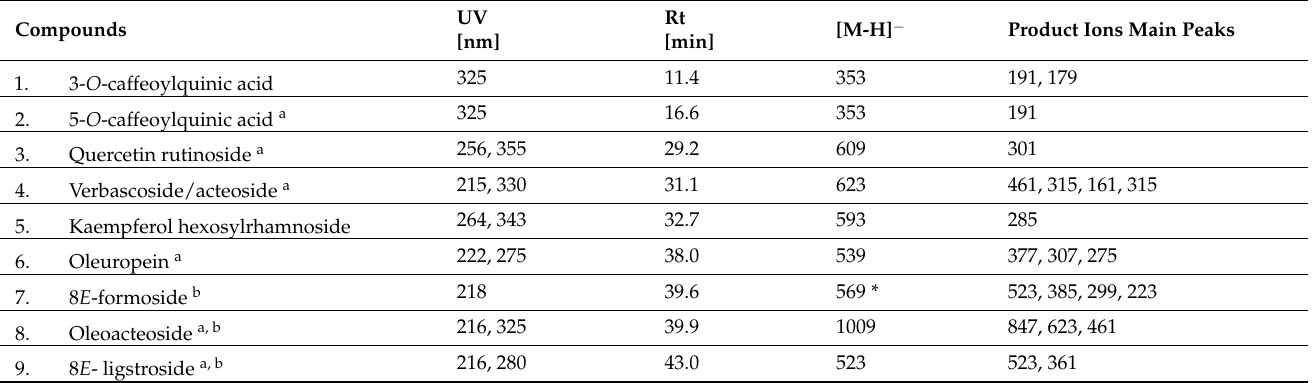
Table 1. Retention time, UV and MS/MS data of compounds identified in ash leaf infusion using UHPLC-DAD-ESI-MS/MS